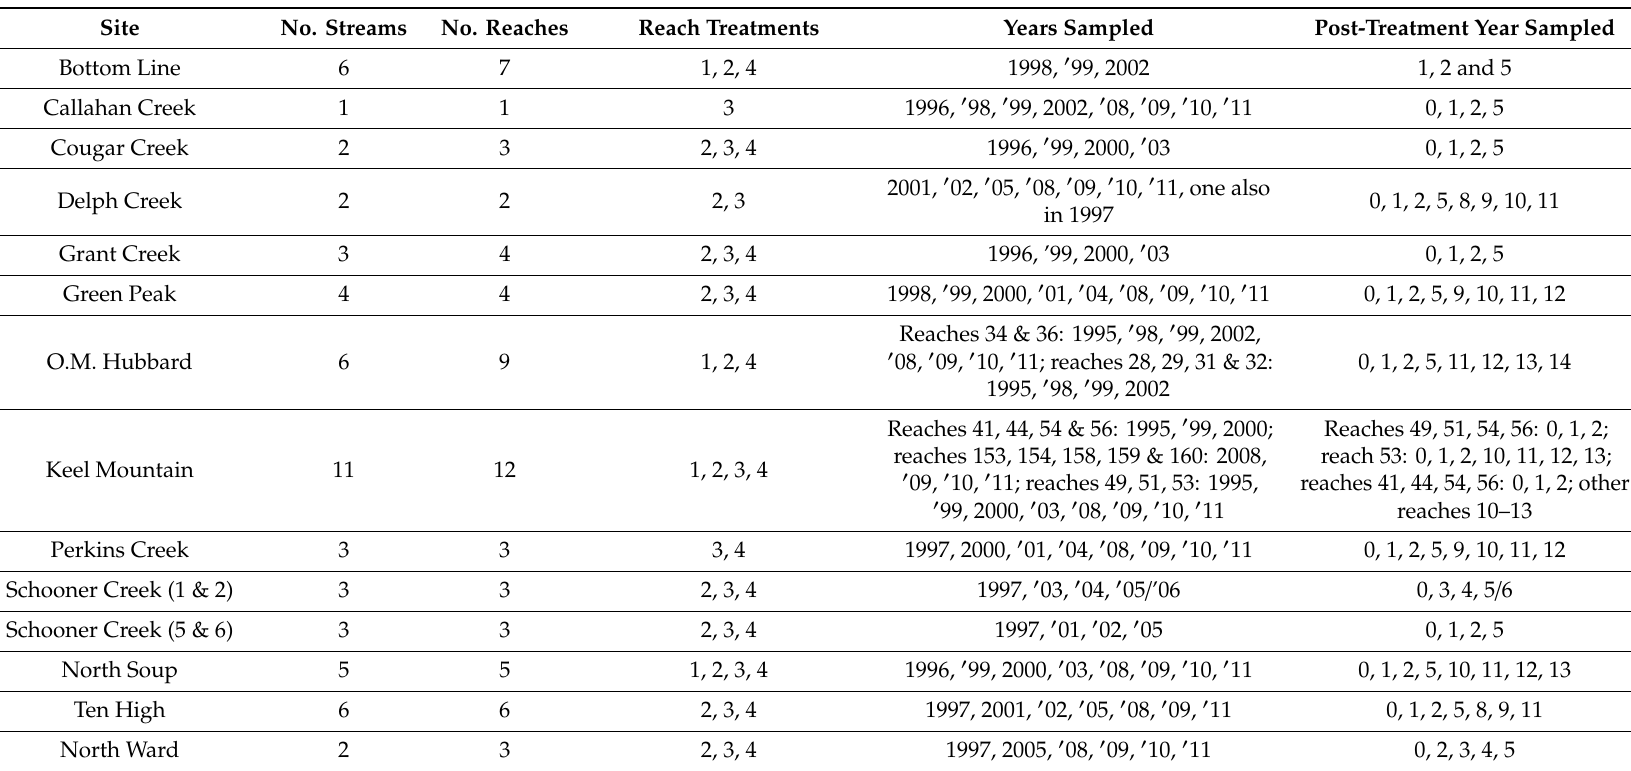
Table 1. Number of spatially intermittent streams and stream reaches sampled by treatment category at each of 13 Density Management and Riparian Bu ff er Study sites in Western Oregon, USA. Reach treatment codes: 1 = one site-potential tree height riparian bu ff er, ~70 m; 2 = variable-width riparian bu ff er with a 15-m minimum width; 3 = streamside retention riparian bu ff er, ~6 m; 4 = control (no upland management during our study). Years sampled spanned 1995–2011 (but not 2007); reach numbers are indicated if there was subsampling in some years due to field logistical constraints. In the column Years Sampled, stream reach numbers within a site are provided if they were field-sampled during pretreatment surveys (indicated as year 0 in last column of table) and in post-treatment years 1–6, and 9–13. No. Streams No.